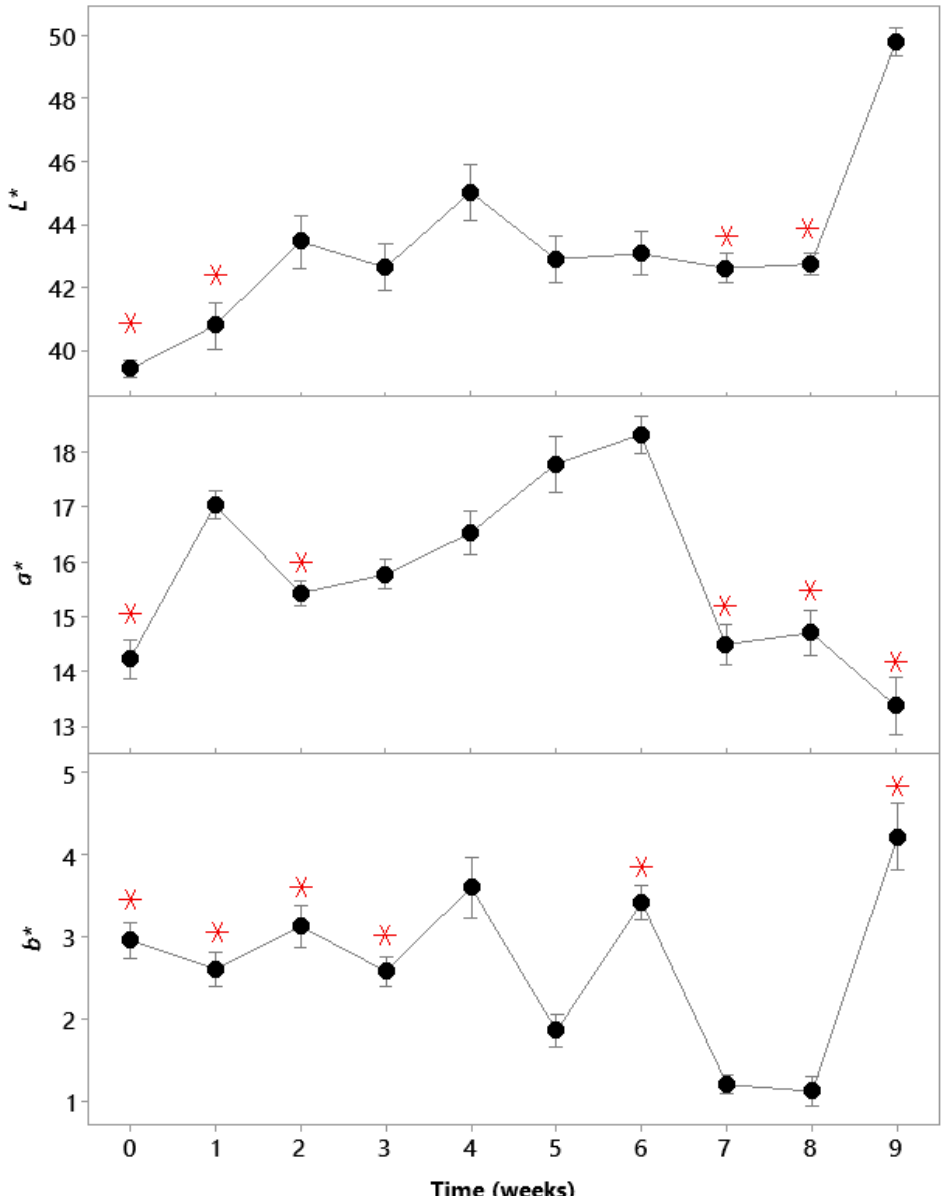
Figure 7. Changes in the CIE L *, a * and b * values of the VP meat during nine weeks of storage. The means labelled with the red asterisk symbols ( ) were not significantly different from the control level mean at time 0 (day 1, week 1) according to the ANOVA test (Dunnet comparisons, α = 0.05). The error bars represent the standard errors of the means.